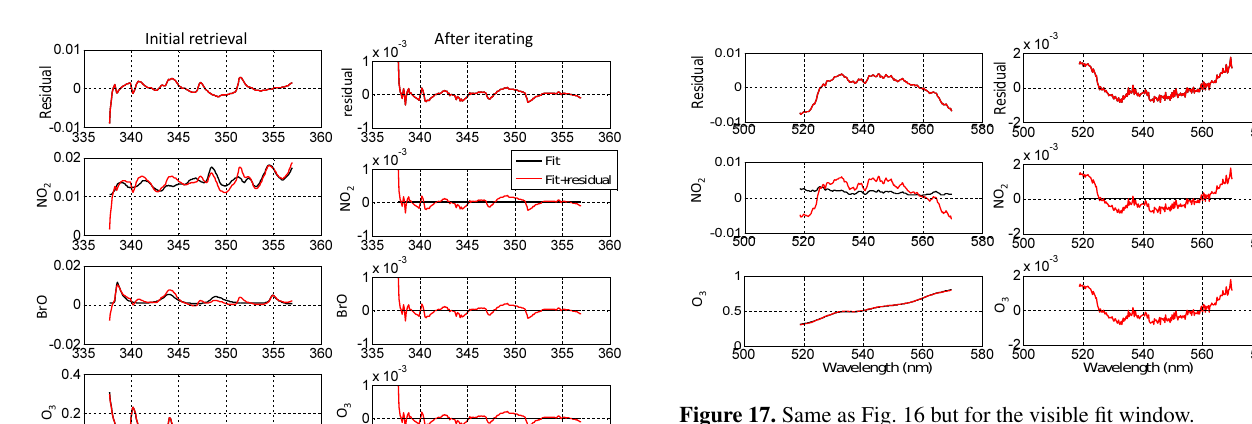
Figure 17. Same as Fig. 16 but for the visible fit